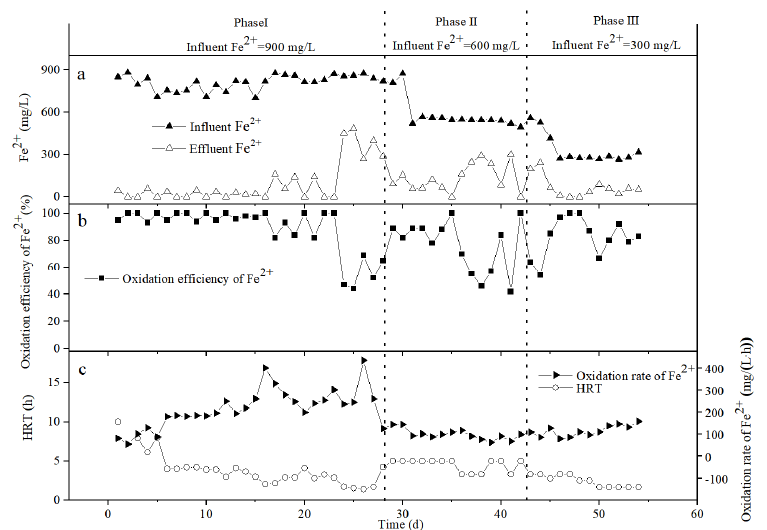
Figure 5. Variation of the Fe 2+ concentration ( a ), Fe 2+ oxidation efficiency ( b ), Fe 2+ oxidation rate, and HRT ( c ) in the influent and effluent of the bio-ceramsite packed column. During days 17–23, the effluent Fe 2+ fluctuated greatly, so we increased the HRT to help the system return to normal. By the 23rd day, the influent Fe 2+ was 871 mg/L, the HRT was 2.89 h, the effluent Fe 2+ was 0, the oxidation efficiency of Fe 2+ was 100%, and the oxidation rate of Fe 2+ was 301 mg/(L ·